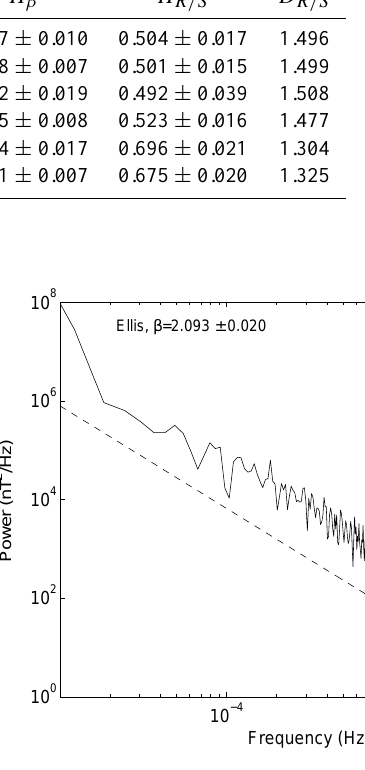
Fig. 3. Power spectra of magnetic data measured during 13–18 Jan- uary 1993 at Ellisras (Ellis). The best-fit line gives a value for the spectral exponent of β = 2 . 093 ± 0 . 020. This line (dashed) is shifted for the purposes of